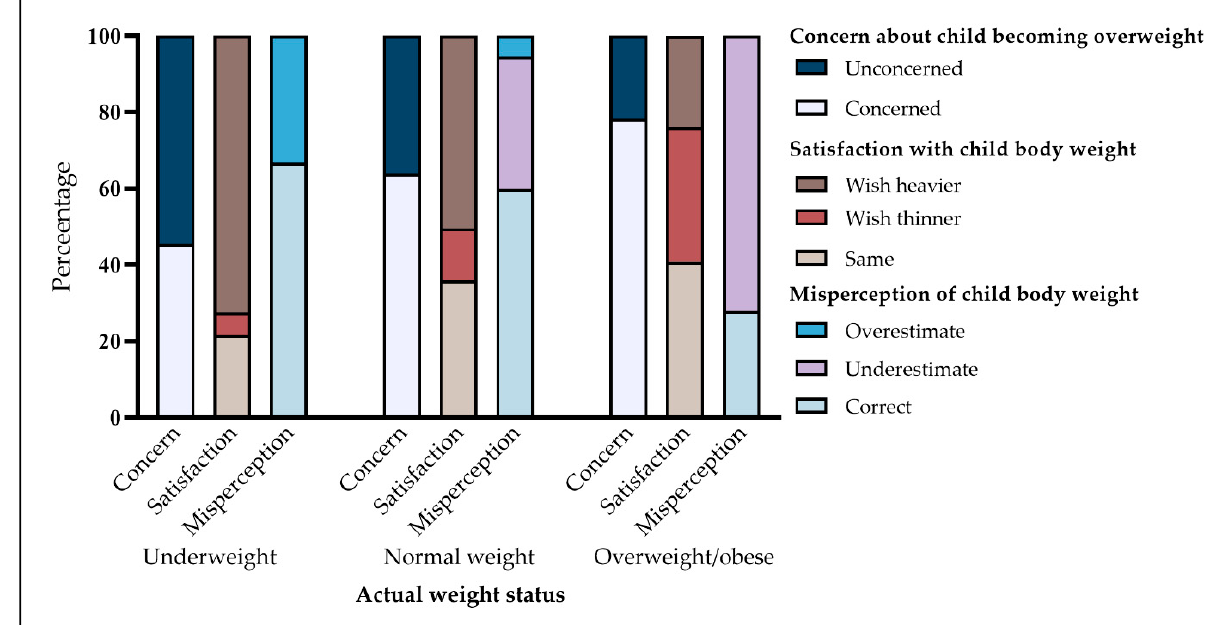
weight (F = 1220.09, p < 0.001).